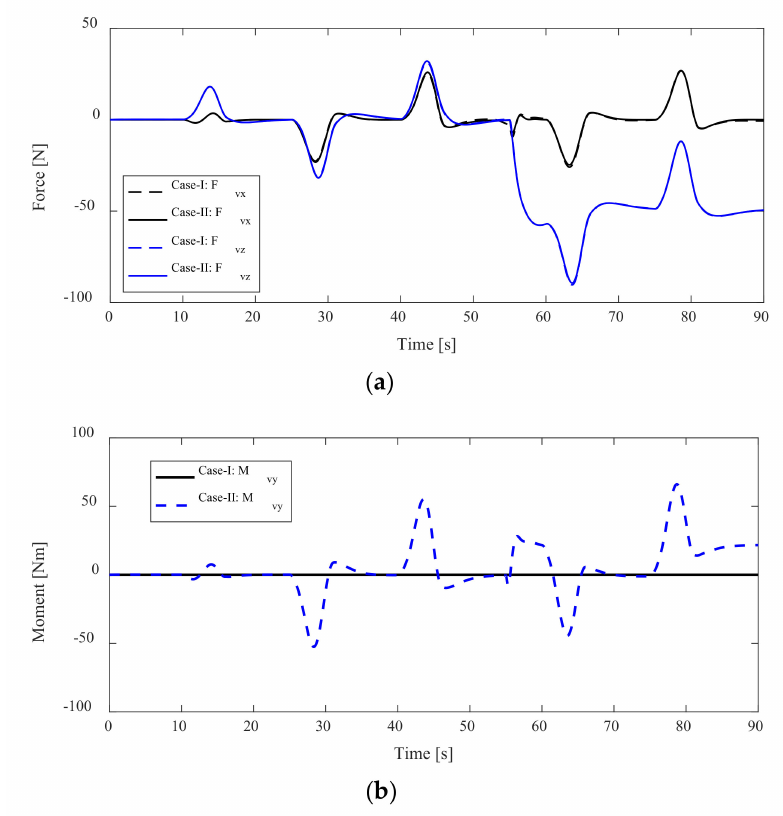
Figure 17. Forces/moments acting on the vehicle: ( a ) forces; ( b ) moments.